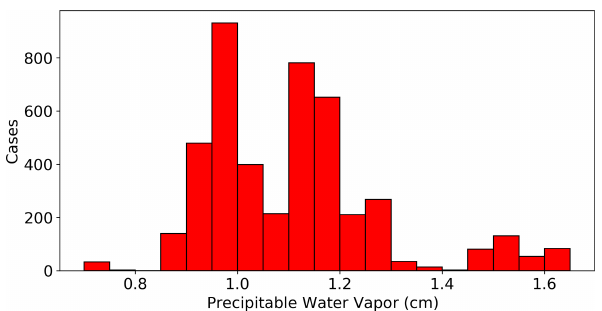
Figure 8. Histogram of the precipitable water vapor during the measurements of atmospheric radiances.